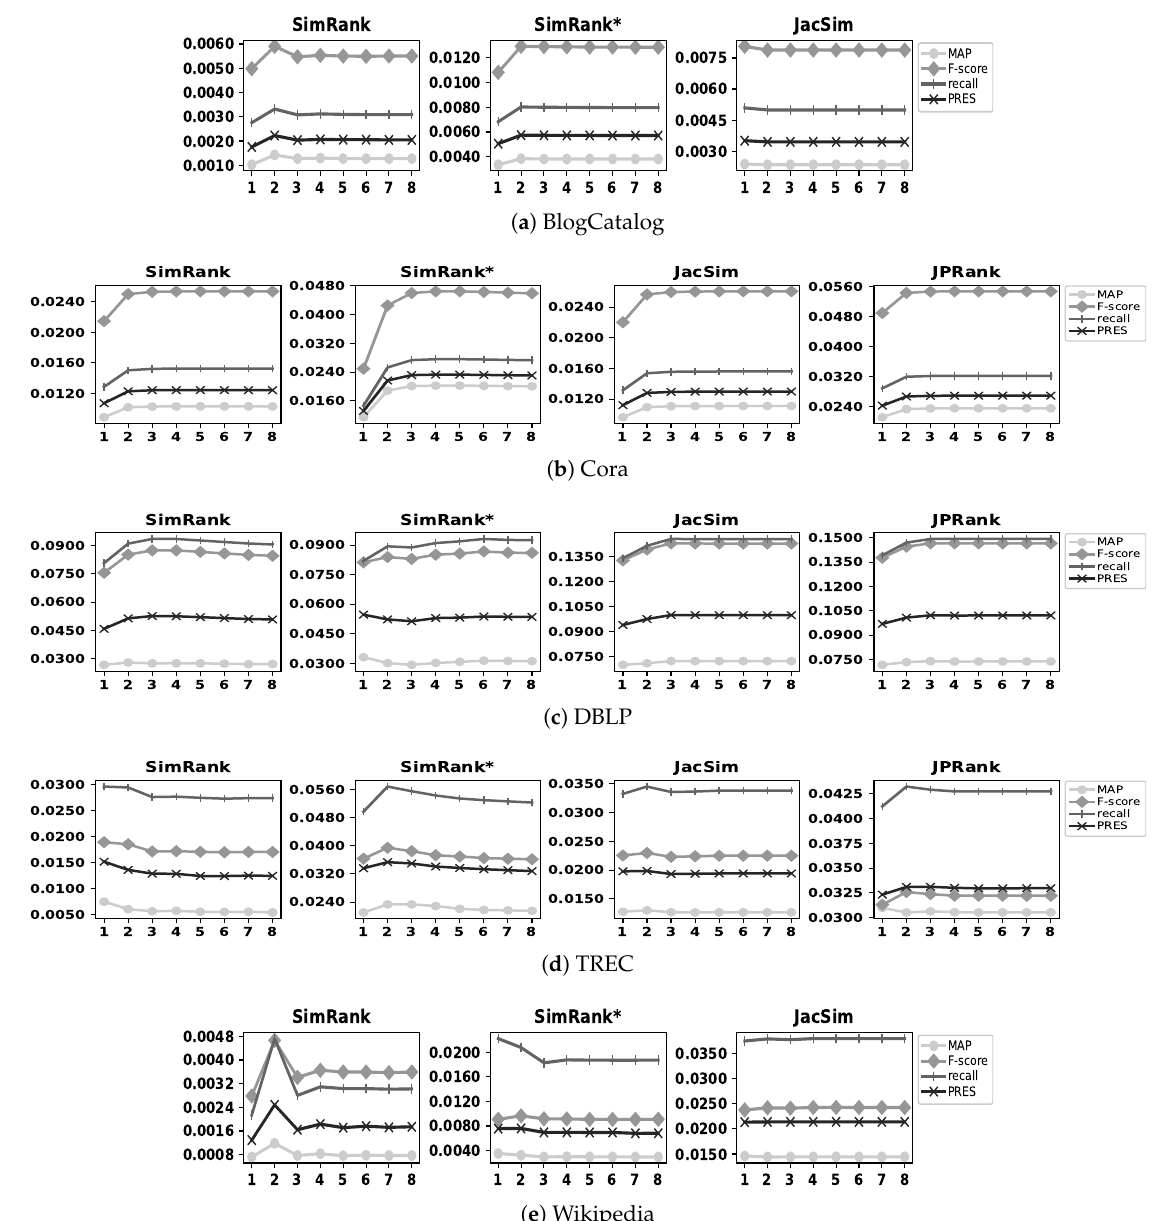
Figure 3. Accuracy of similarity measures with all datasets on eight